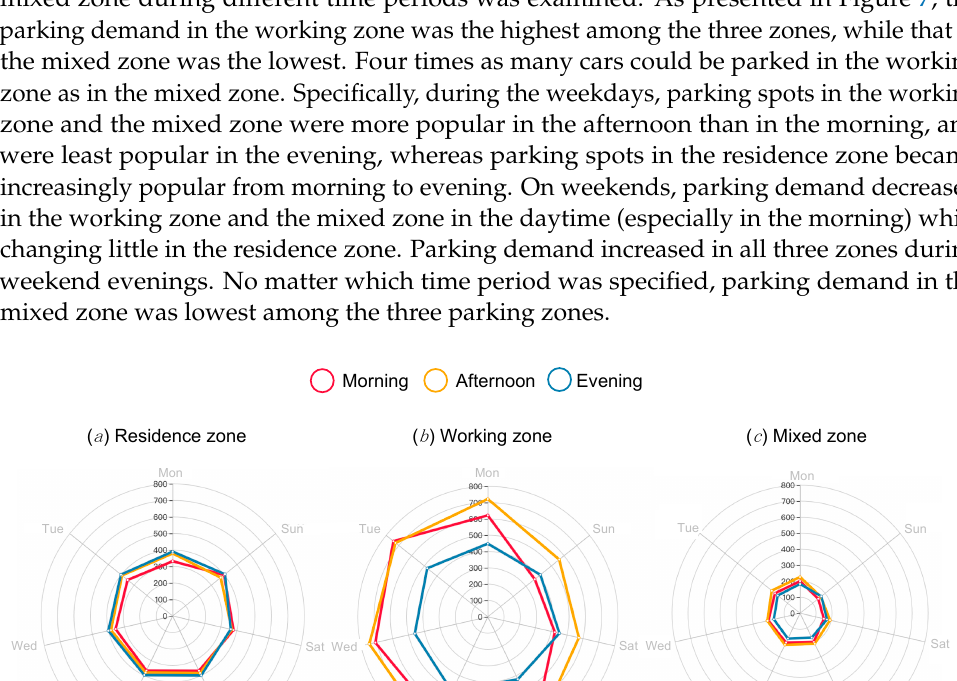
Figure 6. The distribution of four parking zones in the Information Department campus of Wuhan University. The source of the map is OpenStreetMap.